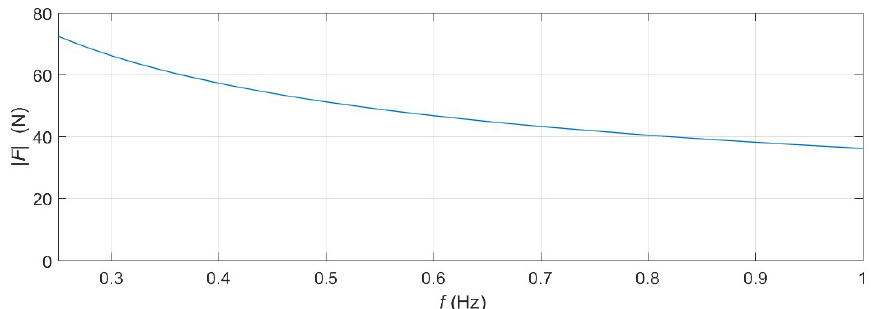
Figure 6. Spectrum of the polychromatic force input signal.